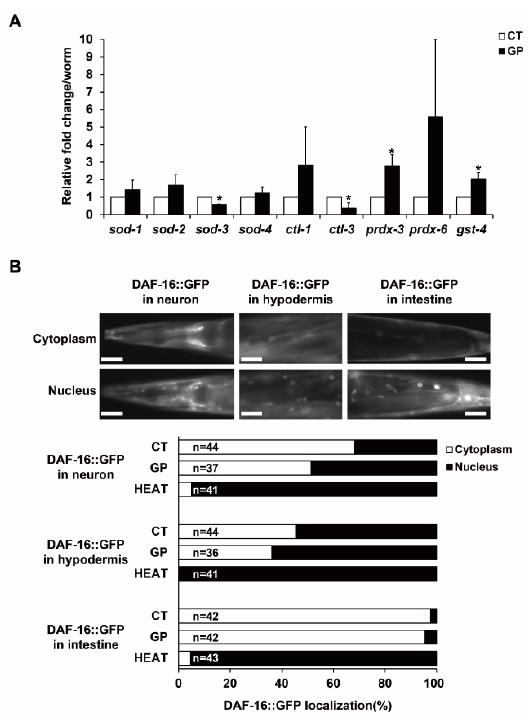
Figure 4. GP intake regulates the expression of antioxidant genes and DAF-16 activity in adult C. elegans . ( A ) The mRNA levels of antioxidant genes in GP-treated adult C. elegans were detected by three independent quantitative reverse transcription-polymerase chain reaction analyses using cdc-42 mRNA in each sample as an internal control for normalization. Error bars represent SD. * p < 0.05 (Student’s t -test). ( B ) Nuclear localization of DAF-16::GFP was observed in worms treated without (CT) or with GP. The graph indicates the percentage of nuclear localization of DAF-16::GFP in neurons, hypodermis, and intestines. HEAT indicates heat shock at 37 °C for 15 min, which is used for the positive control of nuclear localization of DAF-16::GFP. Scale bars are 50 µm.